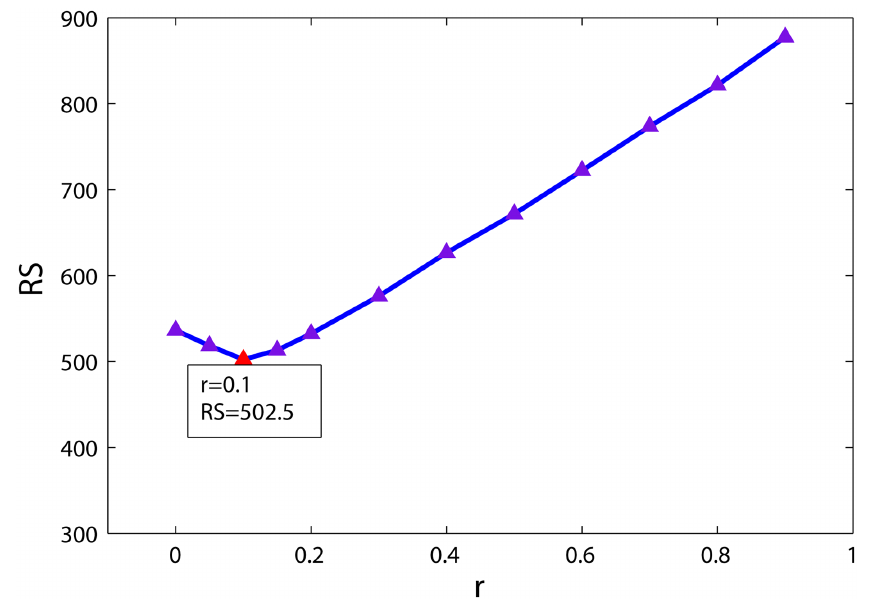
Fig 4. The curve of the correlation between r value and RS value, where triangle presents a r value for a RS value. Red triangle represents the optimal r and its responding RS